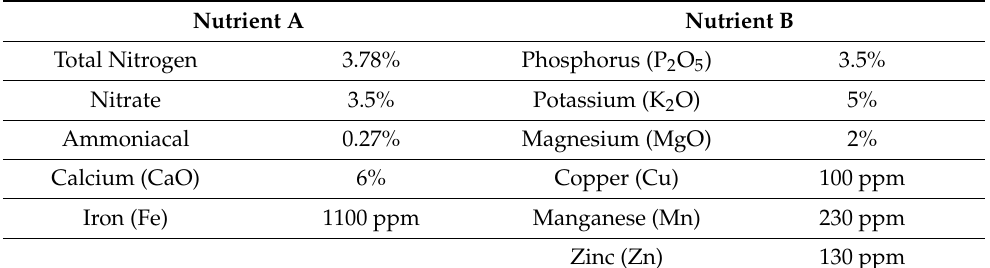
Table 4. Nutrient break down for Greenoponics Growth XL hydroponic nutrient